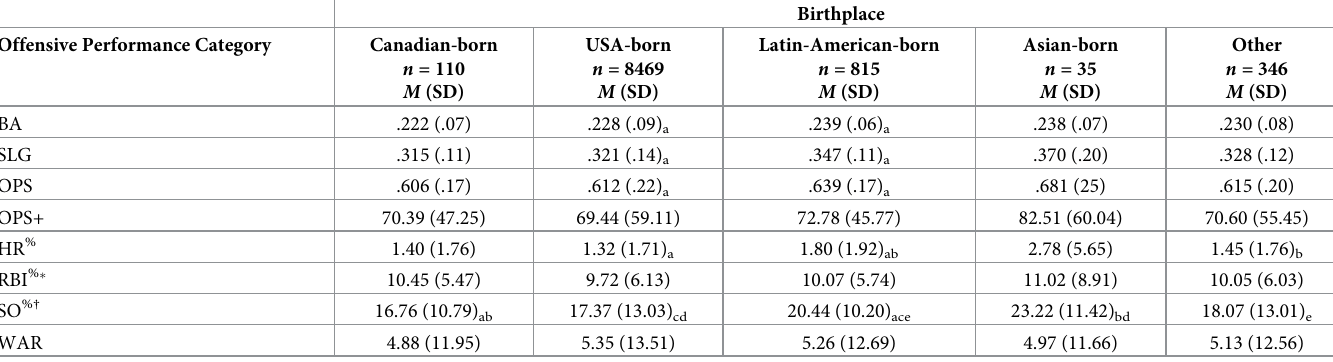
Table 2. Offensive performance values by